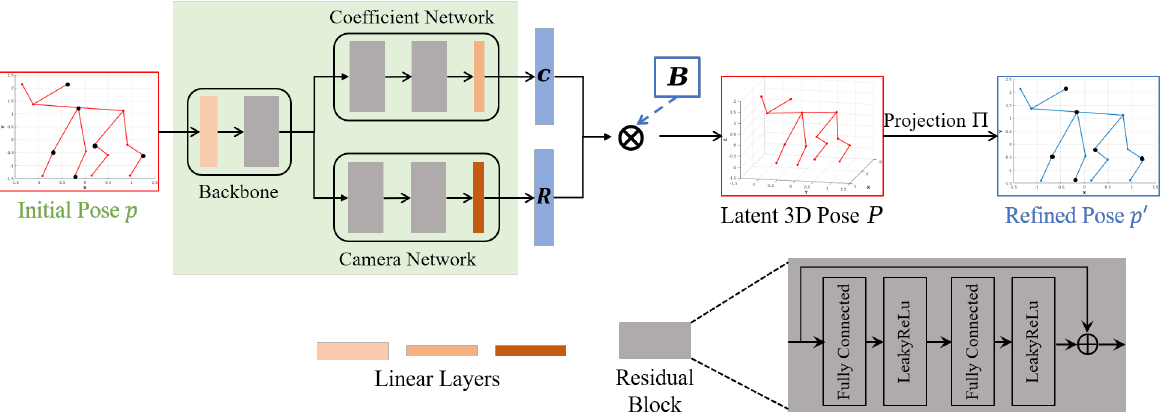
Figure 5. Overview. Given the initial pose p , the coefficient network and camera network estimate coefficients c k and rotation matrix R k in Equation (6), respectively. The coefficients c k and the rotation matrix R k are combined with the 3D pose dictionary B to generate a 3D pose corresponding to the initial pose p . The 3D pose P is reprojected to obtain the refined pose p (cid:48)